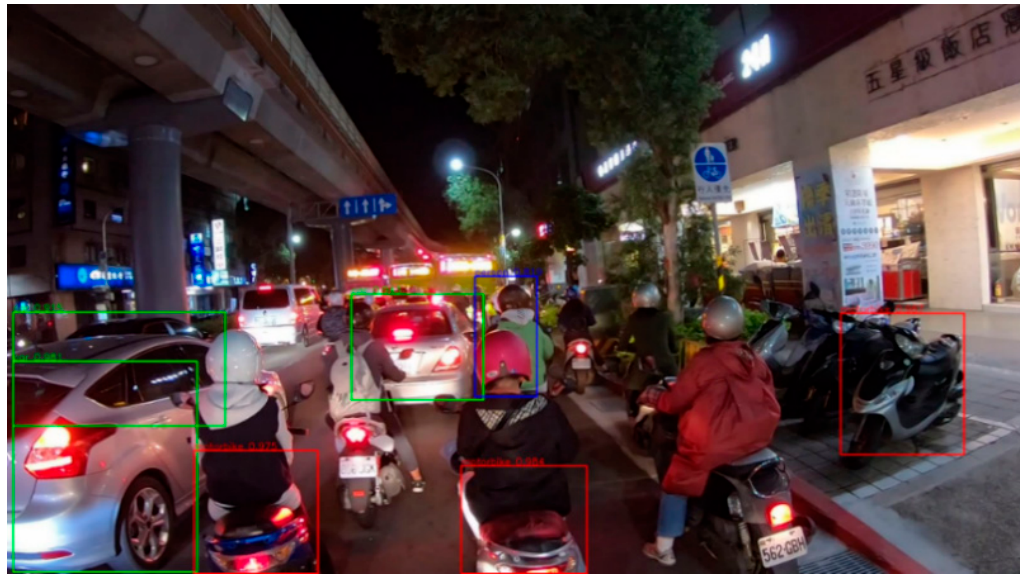
Figure 23. Inference on a 1920 × 1080-pixel nighttime image.